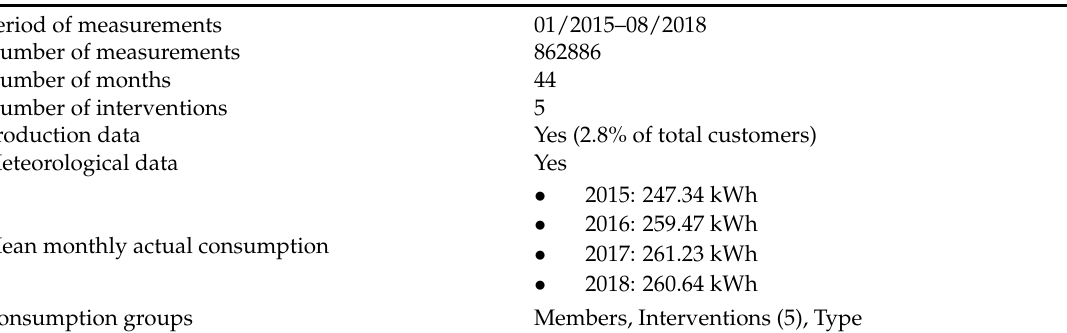
Table 5. Highlights of Som Energia’s dataset.